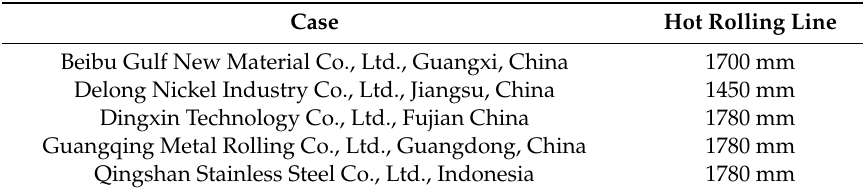
Table 4. Other hot rolling lines with a successful